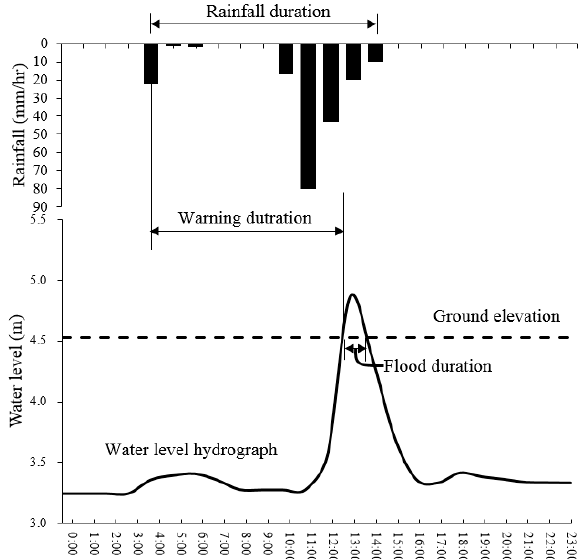
Figure 13. The relationship between warning, rainfall and flood duration. Table 11. The hydrodynamic modeling output for each event’s start time of manhole flooding after the onset of rainfall for the six districts.